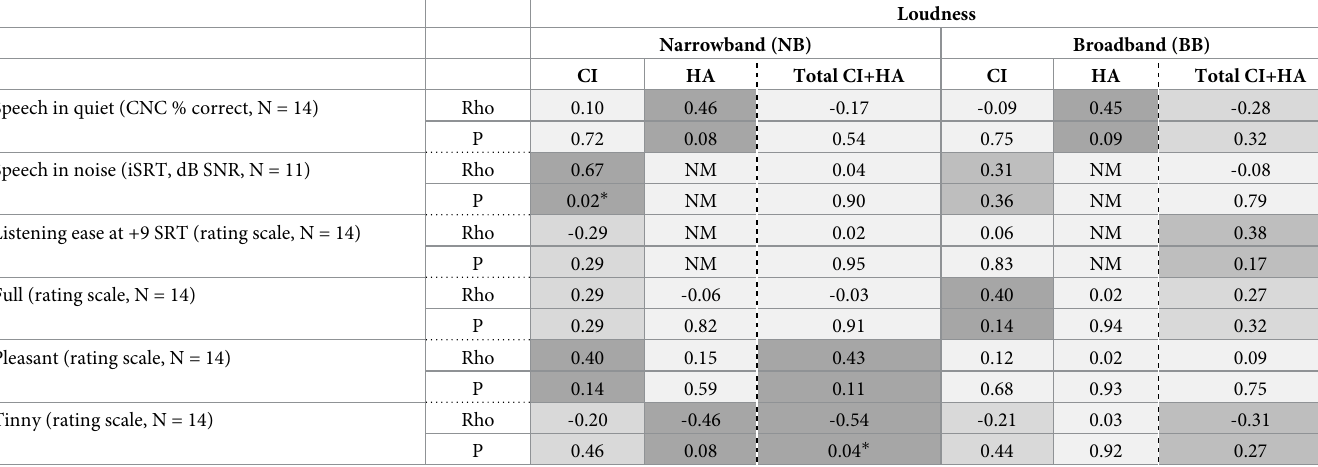
Table 3. Correlations between loudness (AUS for ACALOS listening ease and sound quality) within the same modality (CI, HA and Total